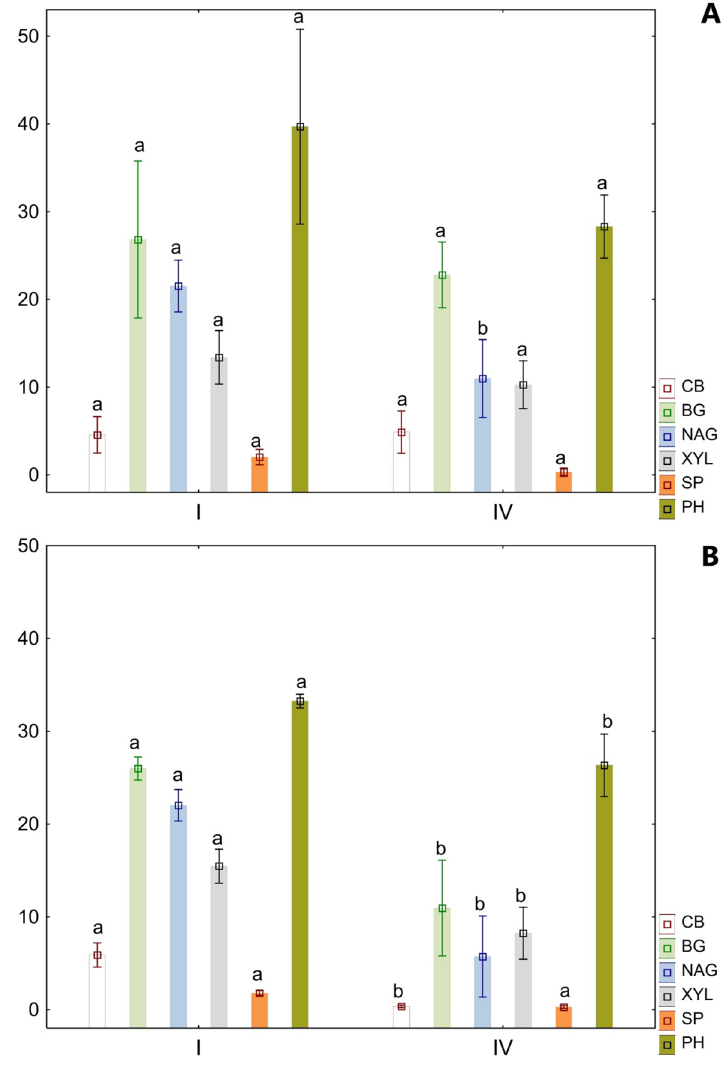
Figure 5. Change in enzymatic activity over time; A – fresh variant; B—dry variant; I, IV – series number; phosphatase (PH), β-glucosidase (BG), N-acetyl-β-D-glucosaminidase (NAG), β-xylosidase (XYL), β-D- cellobiosidase (CB),), arylsulphatase (SP) [nmol MUB . g -1 dry soil . h -1 ]; different letters (a,b) indicate significant differences in enzyme activites between the series of